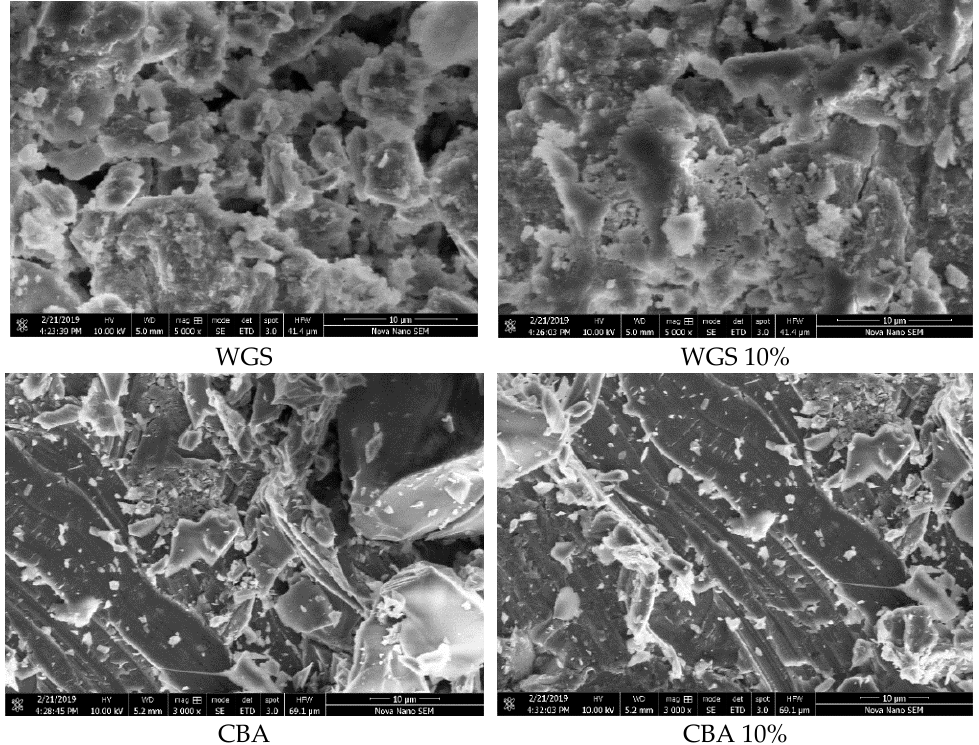
Figure 6. SEM analysis of WGS & CBA.